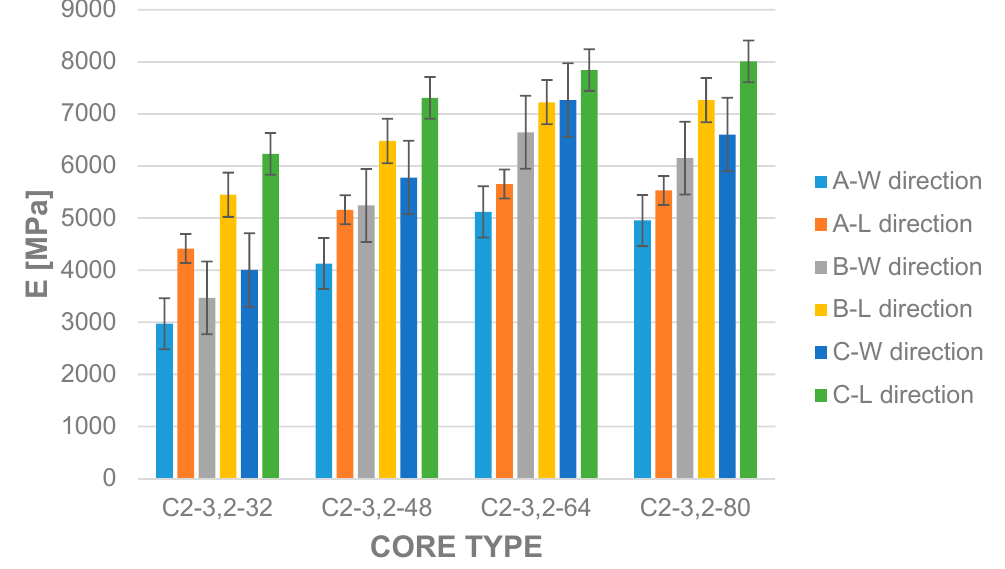
Figure 14. Influence of honeycomb orientation (L and W directions) of various densities on the effective bending modulus of sandwich constructions: types A–C (overview).